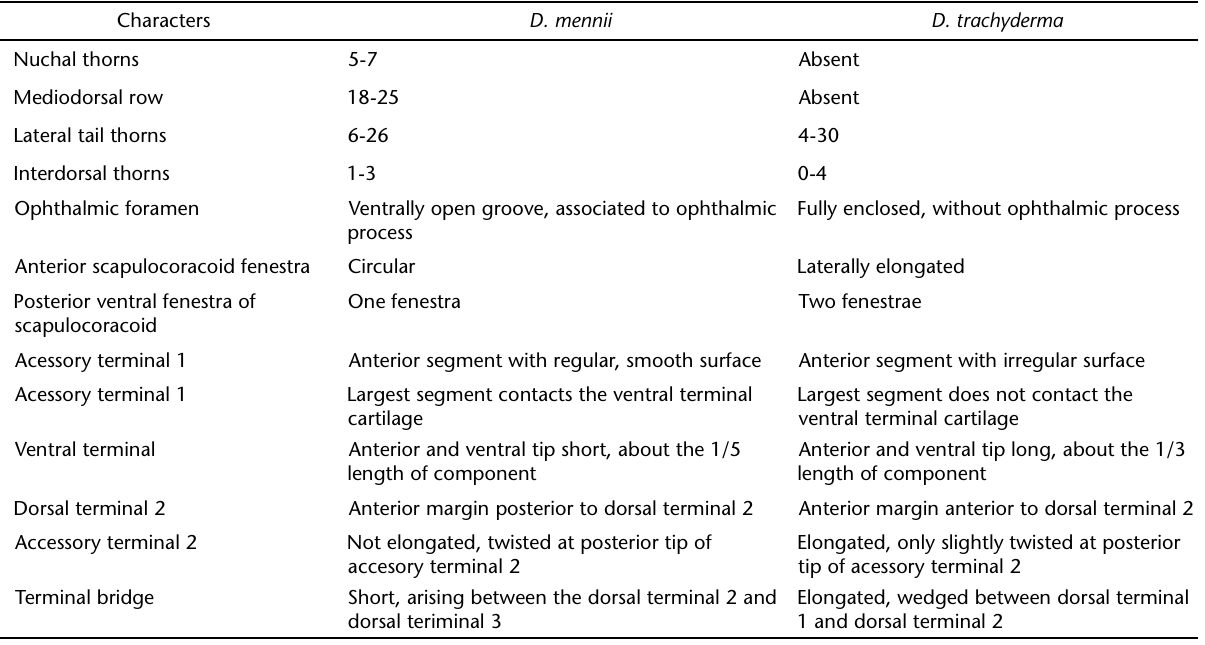
Table VI. Summary of some relevant morphological characters which may distinguish D. menni from D. trachyderma ..